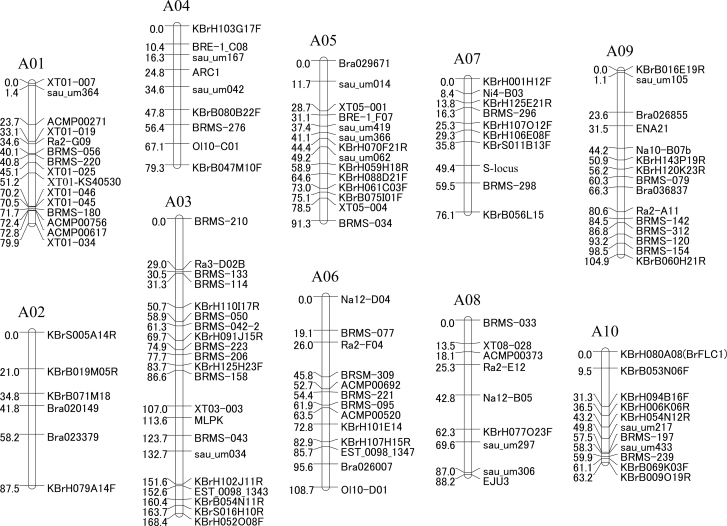
A linkage map of selected DNA markers from the F2 population. Map distances are shown to the left of vertical lines of the linkage group in cM, and marker names are shown to the right.